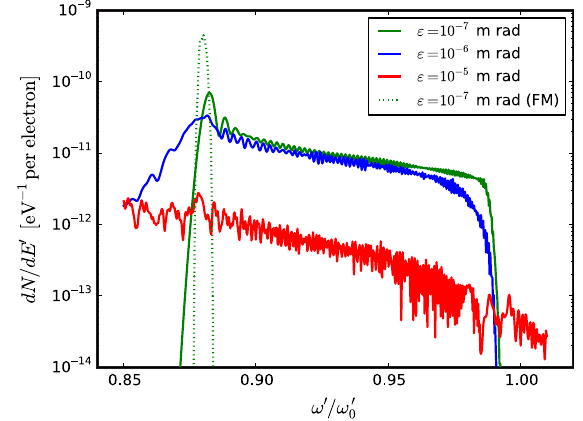
FIG. 4. Effects of emittance on spectral width and height. Back- scattered spectra for the normalized emittance of ϵ ¼ 10 − 7 m rad (green line), ϵ ¼ 10 − 6 m rad (blue line), ϵ ¼ 10 − 5 m rad (red line). Dashed green line represents the spectrum of the ϵ ¼ 10 − 7 case with FM. Electron beam mean energy is E ¼ 360 MeV, energy spread 6 . 5 × 10 − 4 ; laser beam parameters are: a 0 ¼ 0 . 5 , λ ¼ 523 nm, s ¼ σ = λ ¼ 2295 . The aperture used is 1 μ rad. z